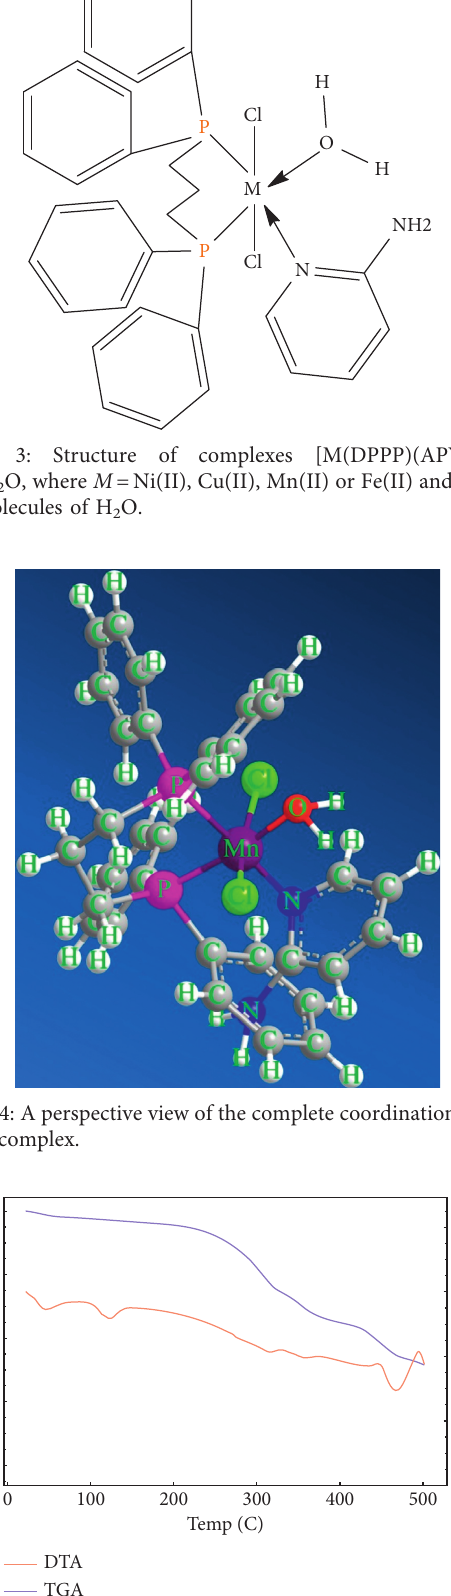
Figure 5: TGA and DTA thermograms of Ni(II)